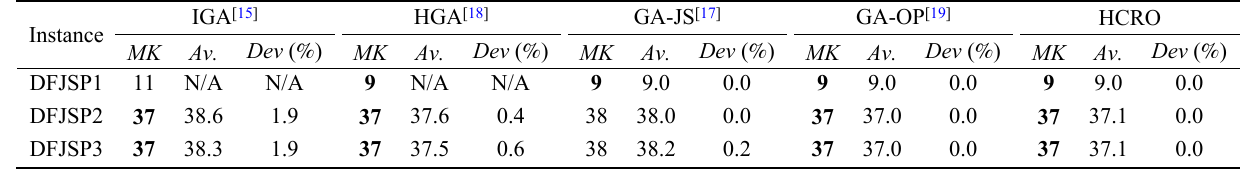
Table 8 Comparison of the results of the algorithms in Experiment